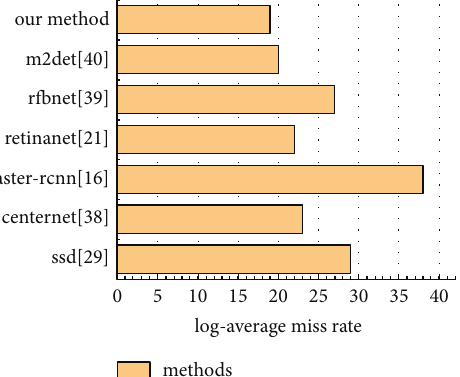
Figure 14: Comparison of missed detection rate of each